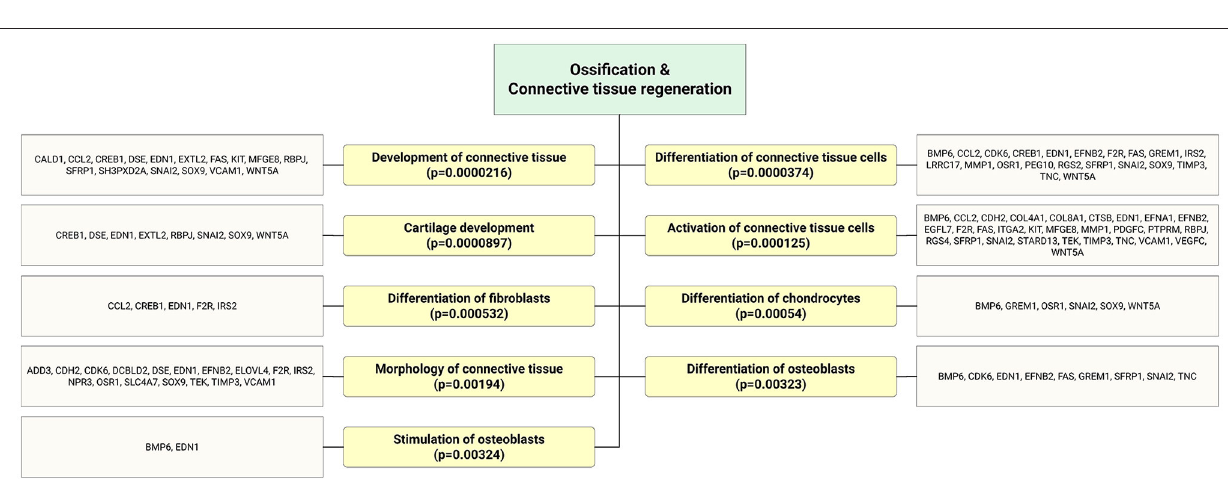
FIGURE 7 | Bioinformatics analysis showed that significantly enriched functional annotation related to bone and connective tissue regeneration. This miR sequence data was generated from PMID: 28631889. MicroRNA target genes were predicted using IPA with information from TargetScan, miRecords, and TarBase